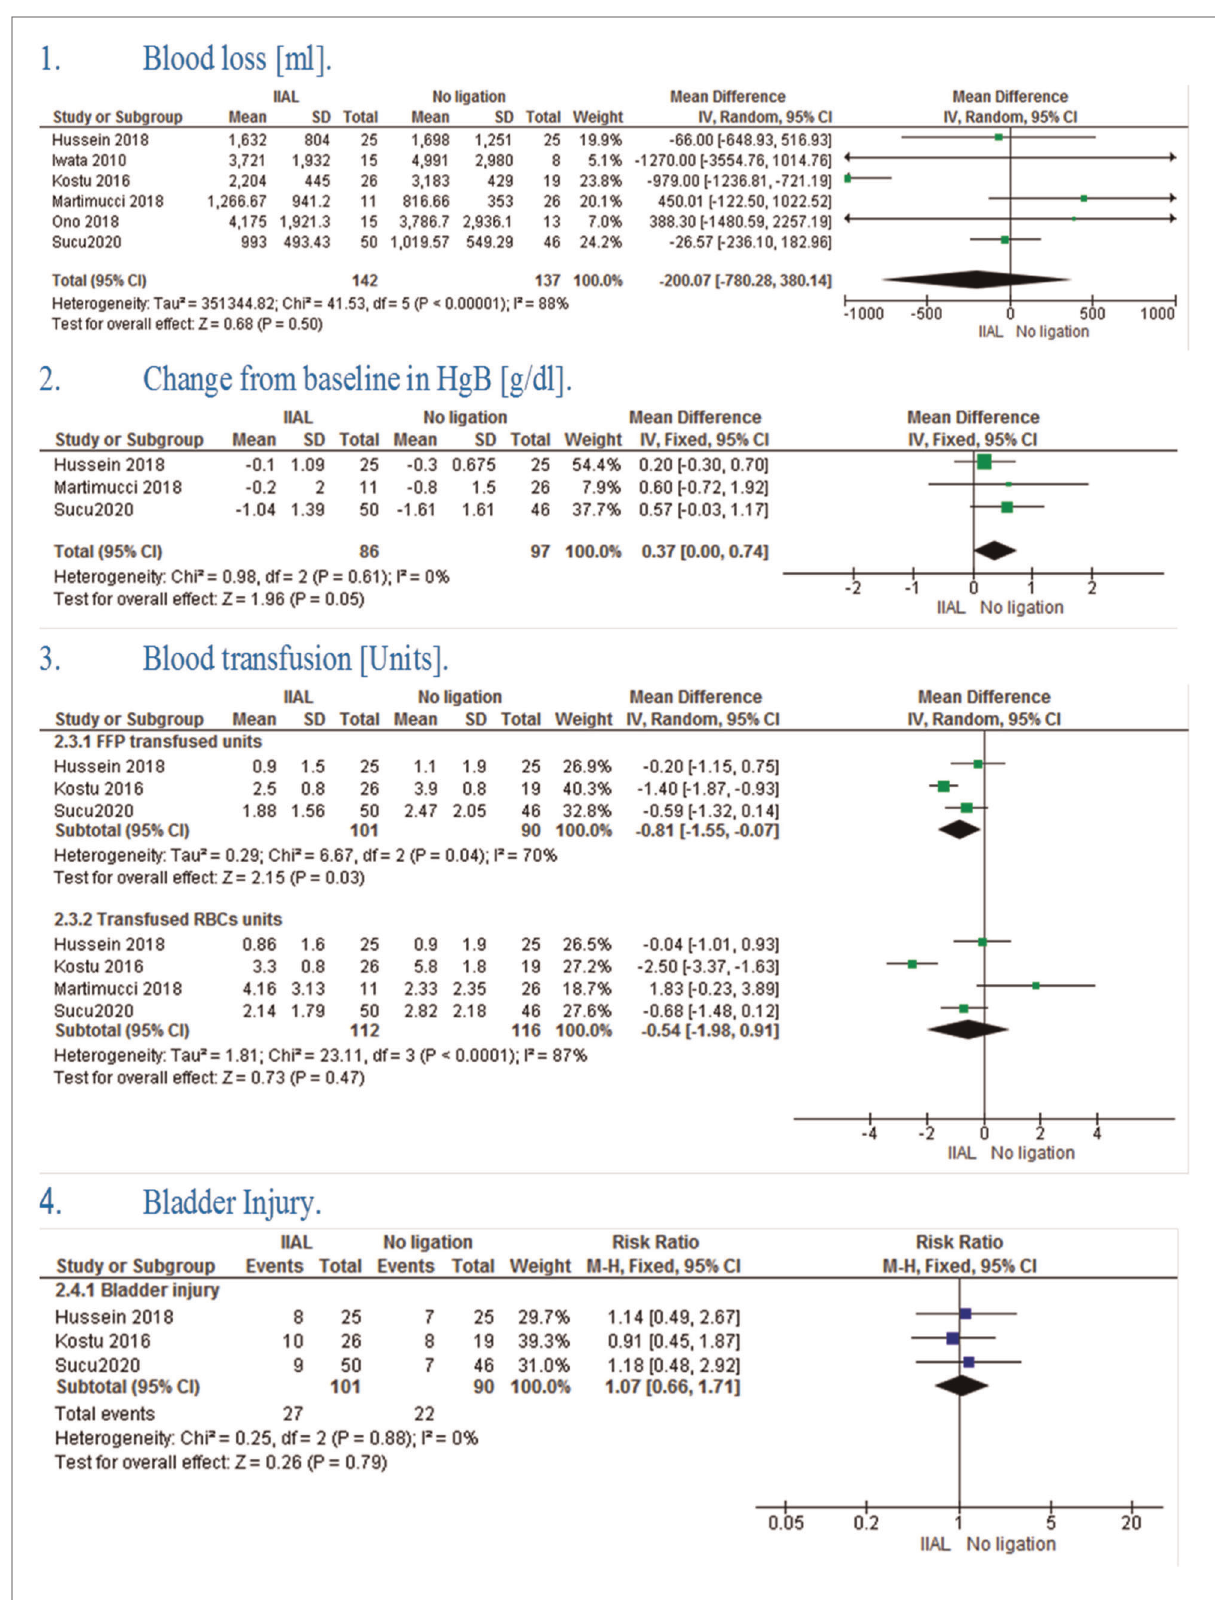
FIGURE 2 Shows the result of IIAL vs. control